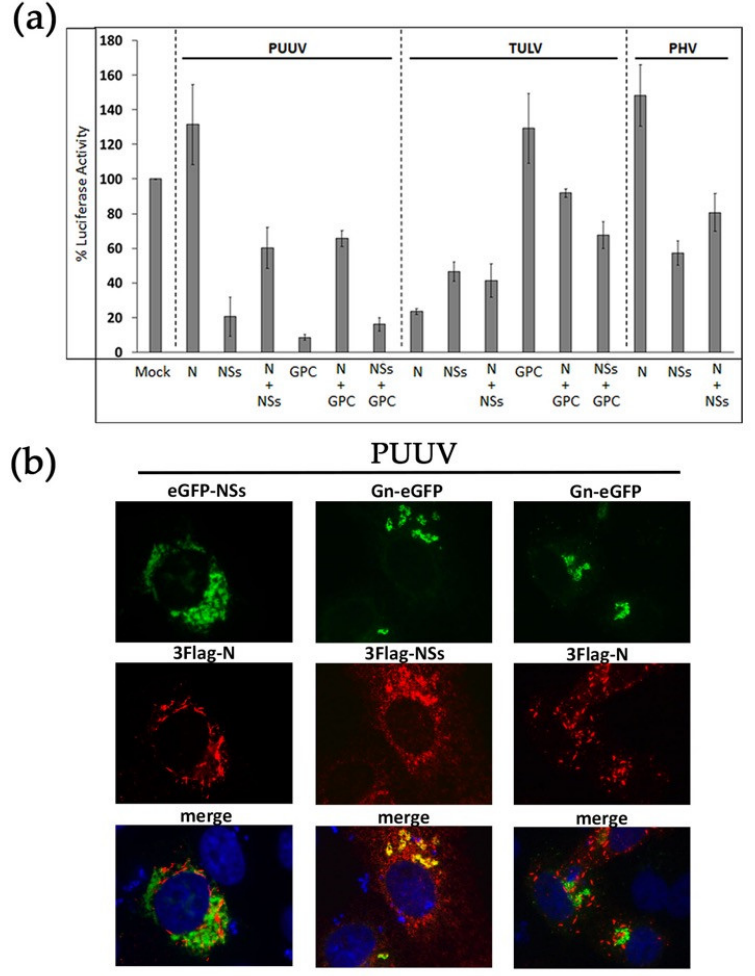
Figure 3. Effect of co-expressing different hantaviral proteins on RIG-I-induced IFN promoter activity and subcellular localization in transfected cells. ( a ) HEK293T cells were transfected with 300 ng of plasmid encoding either 3×Flag-N, 3×Flag-NSs, or StrepTag-GPC individually or in combination (N+NSs, N+GPC or NSs+GPC) using 150 ng of each plasmid. Inhbitory effect of the constructs was measured on RIG-I-induced IFNβ-Luc activity, as described in Figure 1. In ( b ) such combinations of PUUV constructs were co-transfected in VeroE6 cells. Intracellular localization of N with eGFP-NSs (left panels), and of Gn-eGFP with NSs (middle panels) or with N (right panels) were visualized by immunofluorescence. Proteins directly coupled to eGFP appeared in green, and N or NSs tagged proteins stained with anti-Flag mAb, then anti IgG-Alexa 555, appeared in red. The nuclei were labeled in blue with DAPI. The merge panels are shown at the bottom of the figures and co-localizing proteins appearing in yellow. The images obtained using an objective x63 are at the same magnification In the case of PUUV, while the N protein did not inhibit the IFN pathway and NSs protein reduced the IFNβ-Luc activity to 20%, a mix of the two proteins led to 60% of luciferase activity, which suggested that N weakened the effect of NSs protein. The same was observed when mixing the N and the GPC constructs of PUUV. In this case, the IFN promoter-driven activity raised 70%, despite the low level of IFN activity detected follow- mixing GPC and NSs constructs, they both efficiently antagonized IFN signaling and the resulting IFN activity was reduced to 17%. We also looked at the cellular localization of